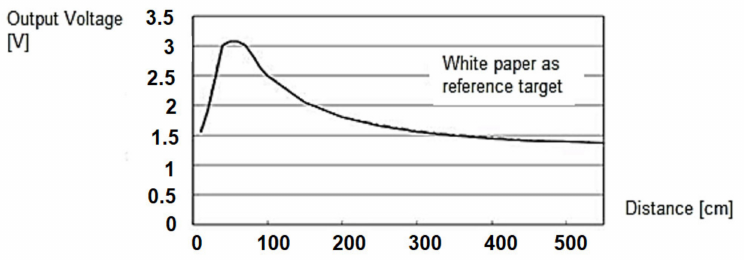
Figure 2. Sensitivity over distance for the obstacle detection sensor (reference target: white paper).